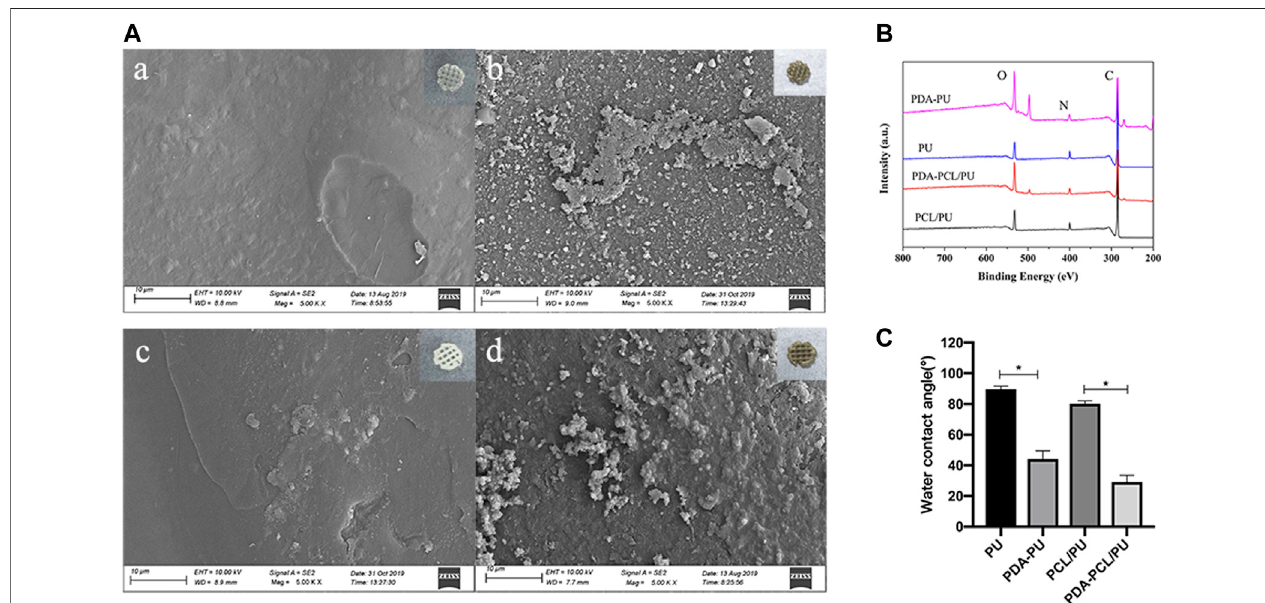
FIGURE2| Characterizationofthe3Dprintedscaffolds. (A) SEMmicrographsandgrossimagesofthescaffolds: (A) PU; (B) PDA-PU; (C) PCL/PU; (D) PDA-PCL/ PU. The gross images at the upper right corner. (B) XPS spectra of scaffolds. (C) Water contact angle of scaffolds (n (cid:2) 3, * p < 0.05).